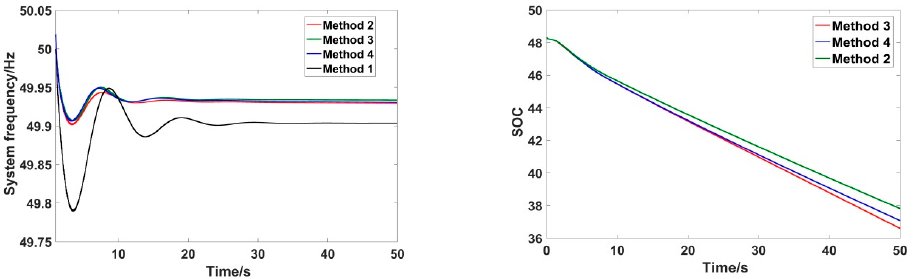
Figure 16. Results of 22 MW step load disturbance. Figure 15. Results of 20 MW step load disturbance of.